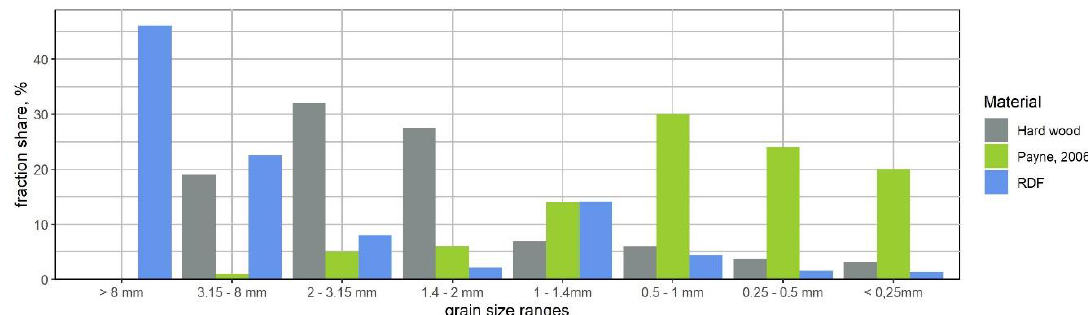
Figure 3. Grain size distribution comparison of biomass and refuse-derived fuel (RDF) grists from a knife mill [49]. Payne, 2006 is optimal grain size distribution to produce high quality biomass pellets [40] .